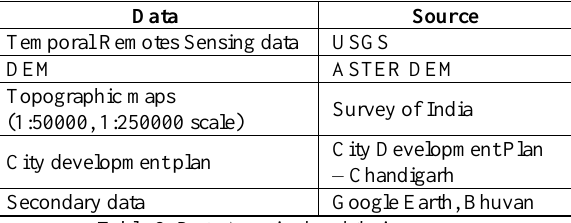
Table 2: Data Acquired and their sources